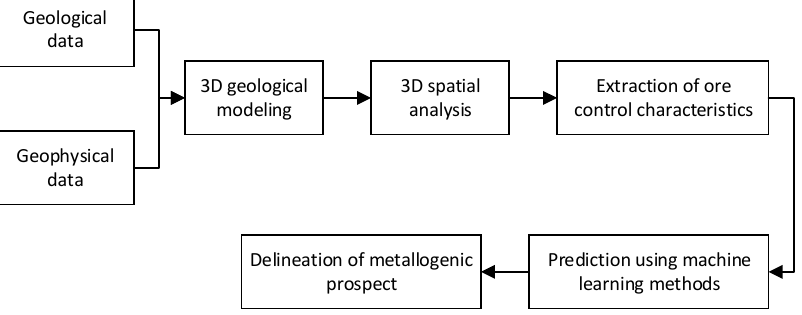
Figure 1. Workflow of three-dimension prospectivity mapping.